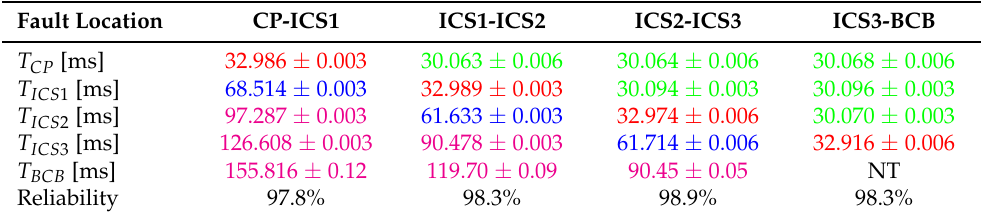
Table 9. Results obtained in rural areas.